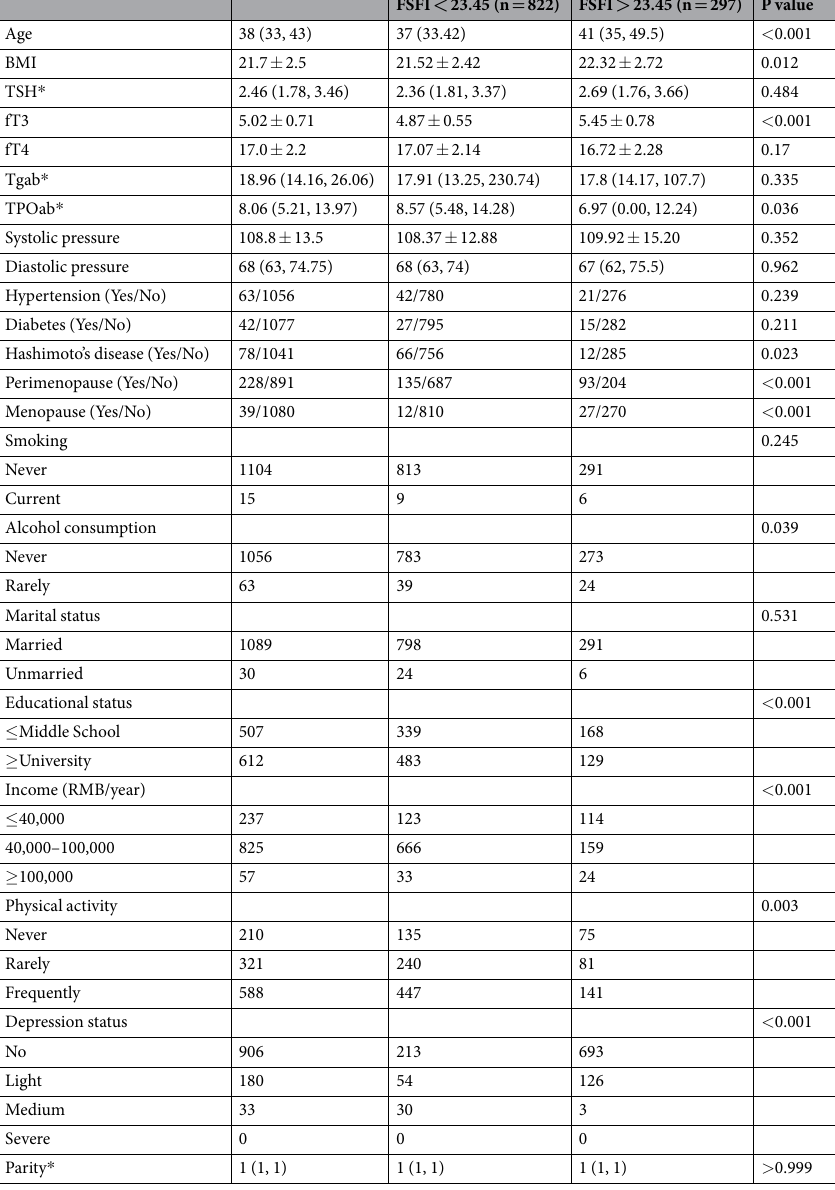
Table 1. Basic characteristics of the participants. fT3: free triiodothyronine; fT4 : free thyroxine; TPOab : thyroid peroxidase antibody; Tgab : thyroglobulin antibody; TSH: thyroid stimulating hormone; BMI: